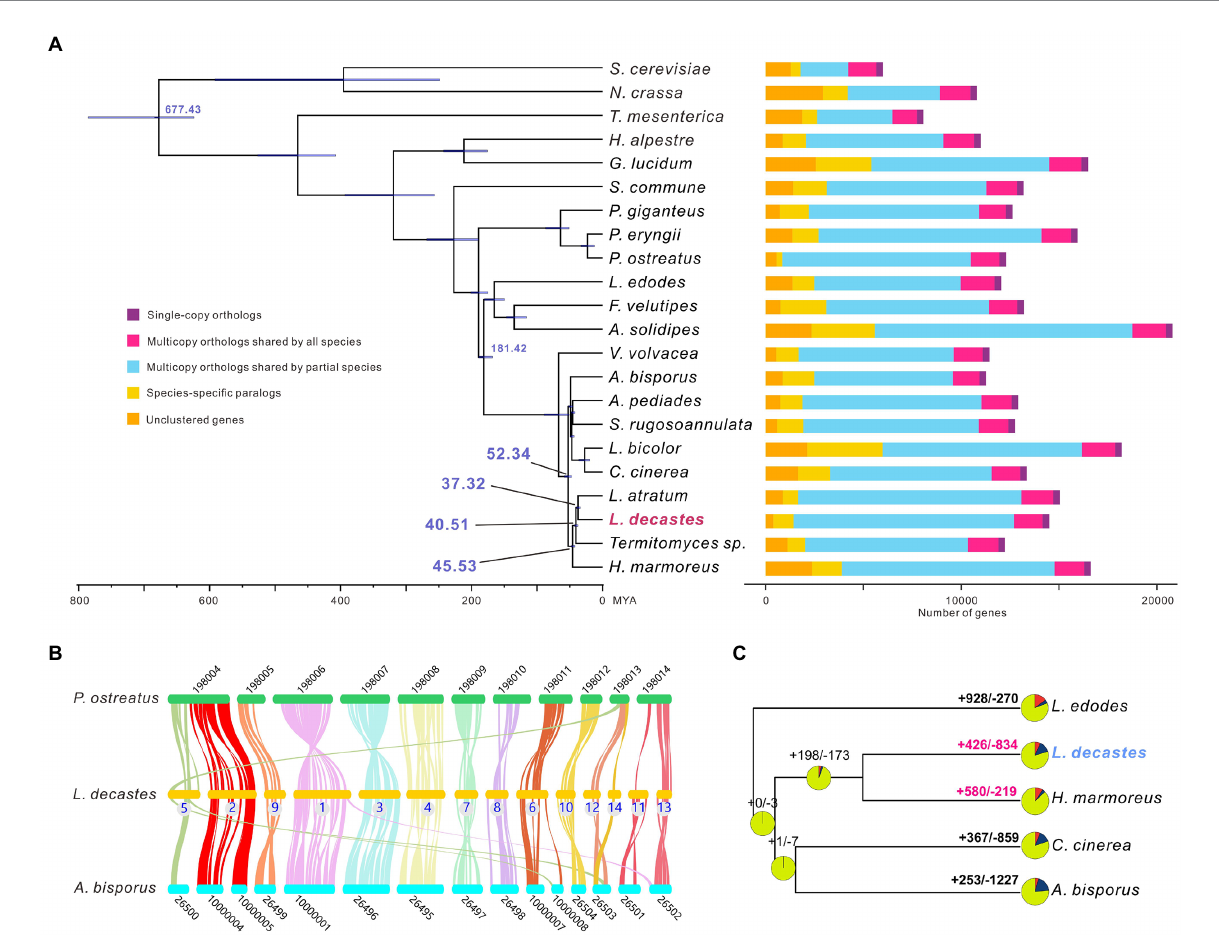
FIGURE 3 Evolutionary and comparative genomic analysis of Lyophyllum decastes . (A) Fungi phylogenetic tree. Phylogenetic tree inferred from 346 single-copy orthologs among 22 fungi species identified using OrthoFinder. Divergence timings were indicated using transparent blue bars at the internodes with 95% highest posterior density. Single-copy orthologs are defined as orthologs that were present as a single-copy gene in all 22 species. Multicopy orthologs shared by all species represent the gene groups present in all species with a gene number of >1 in at least one species. Multicopy orthologs shared by partial species represent gene groups present in more than one and less than 22 species with a gene number of >1 in at least one species. Species-specific paralogs represent genes uniquely present in only one species. Other genes are classified as unclustered genes. (B) The genome collinearity among L. decastes , P. ostreatus , and A. bisporus . Each line connects a pair of collinearity blocks between two genomes. (C) Gene family expansion and contraction analysis between five fungi including L. decastes